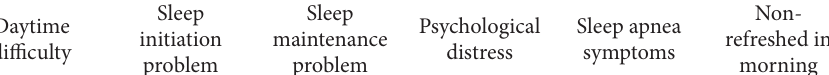
Table 3: Factor loadings of 34 Sleep Questionnaire and Sleep Symptom Checklist